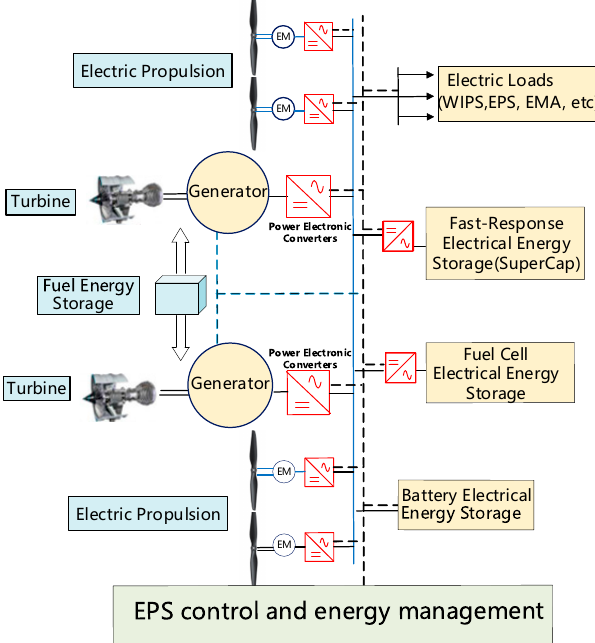
Figure 18. The power system architecture of hybrid electric propulsion